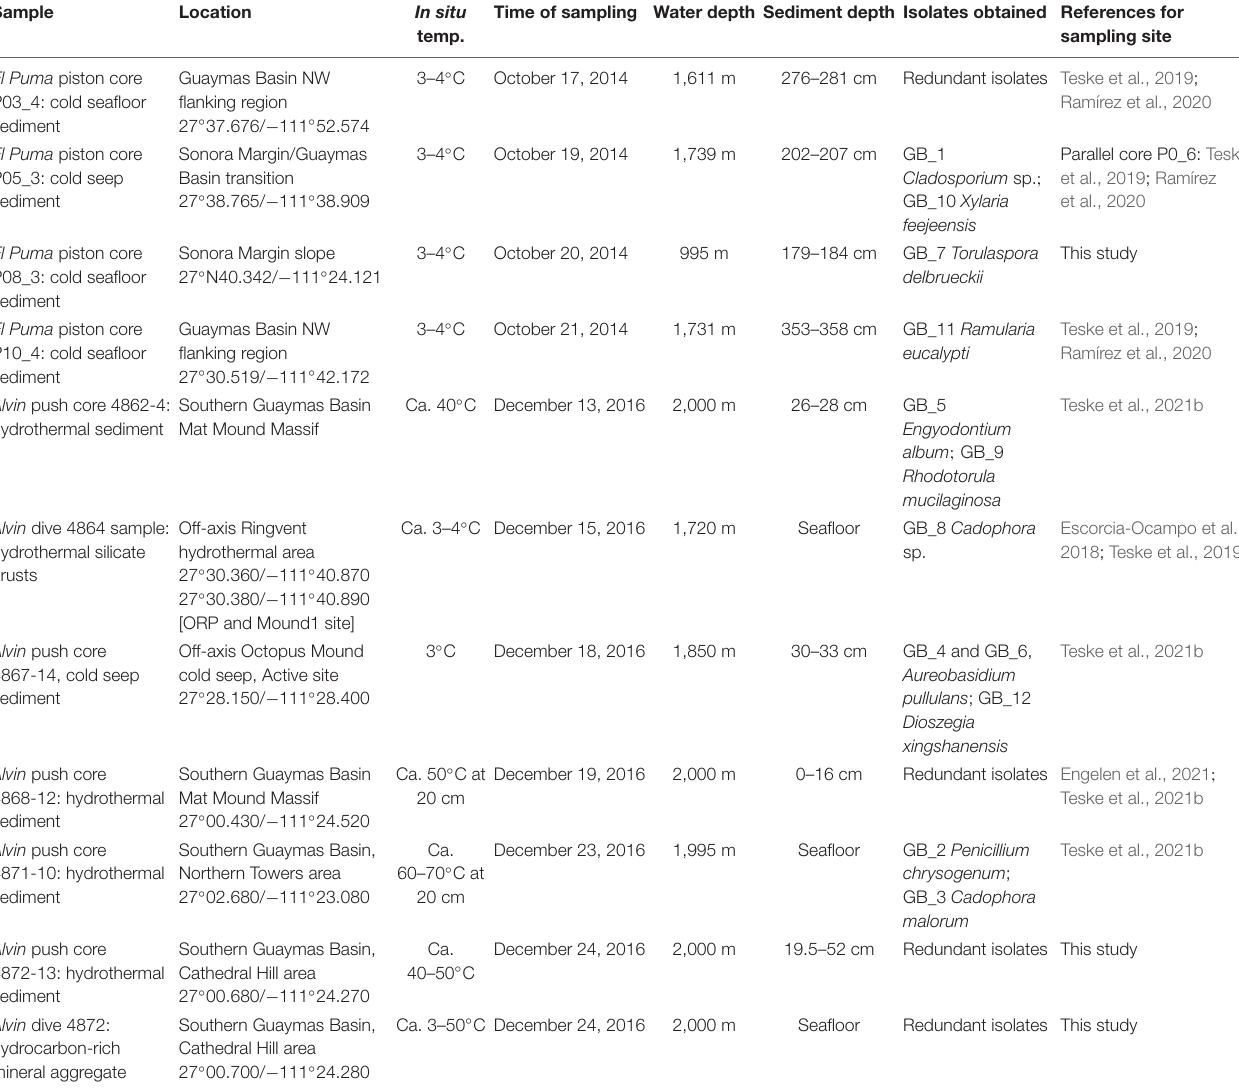
TABLE 1 | | Sample site key for published fungal isolates from Guaymas Basin (Keeler et al., 2021; sampling key not reported therein). Sample Location In situ